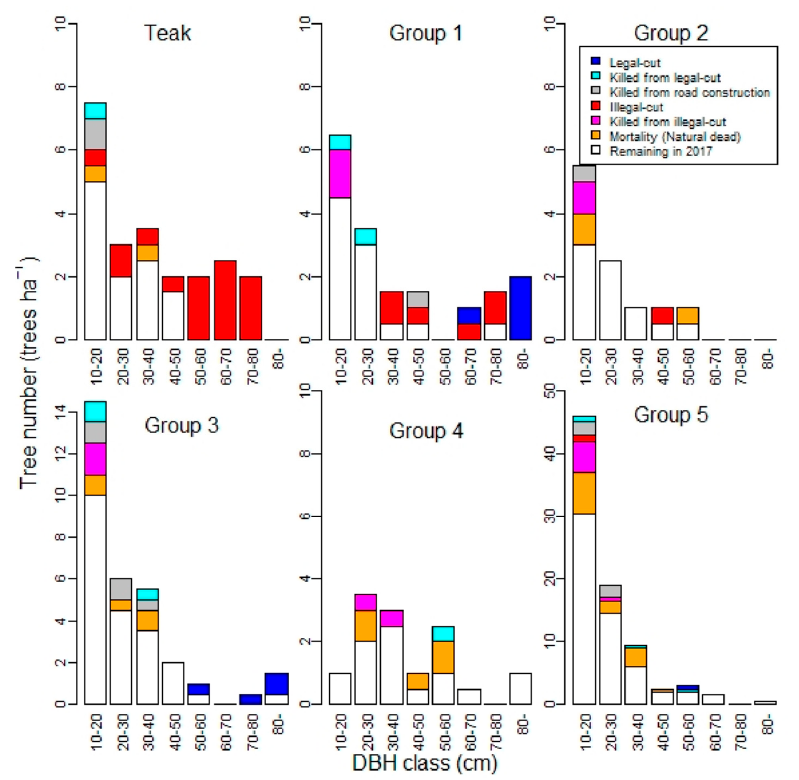
Figure 3. DBH distribution for each species group in Compartment 93, South Zamaye Reserved Forest, Bago Yoma, Myanmar, in 2012 and their classifications in 2017.